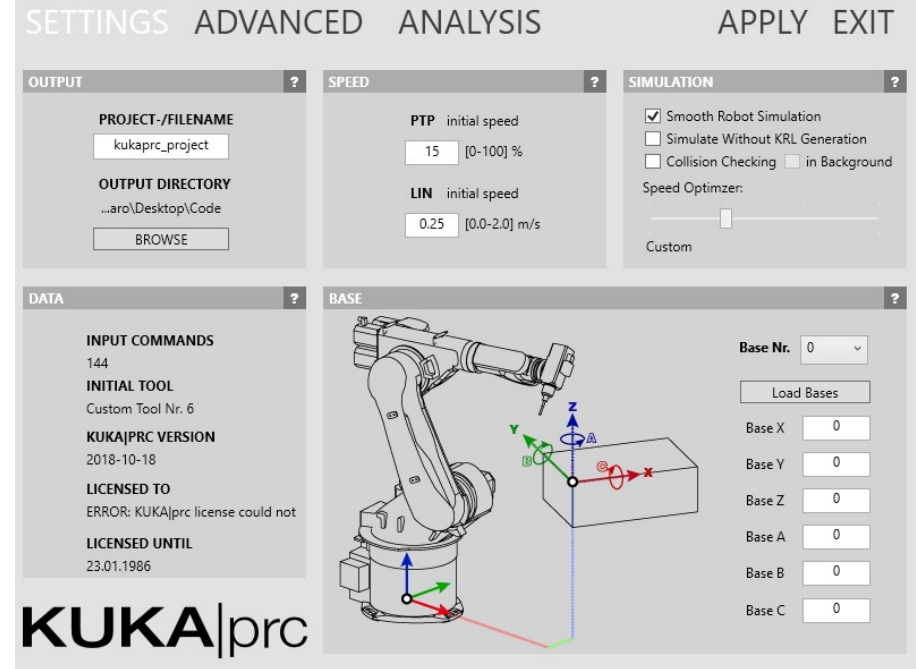
Figure A11. Interface KUKA PRC CORE.